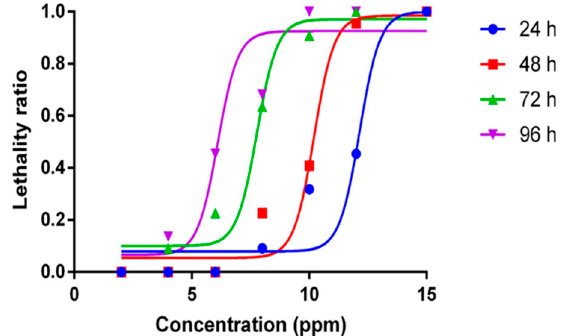
Figure A1. LC 50 test of ZnCl 2 in adult zebrafish. Adult zebrafish were incubated with different concentrations of ZnCl 2 (2, 4, 6, 8, 10, 12, and 15 ppm) and the fish number was recorded every day to build up the mortality curve. LC 50 curves at 24, 48, 72 and 96 h are labeled in blue, red, green, and purple, respectively.